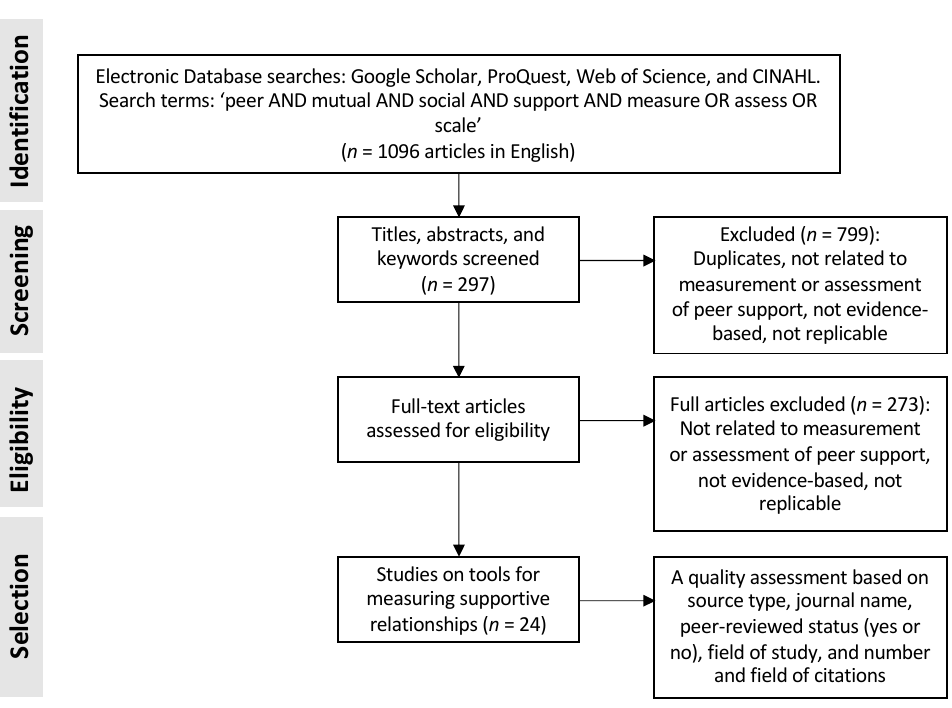
Figure 1. Systematic literature review process.